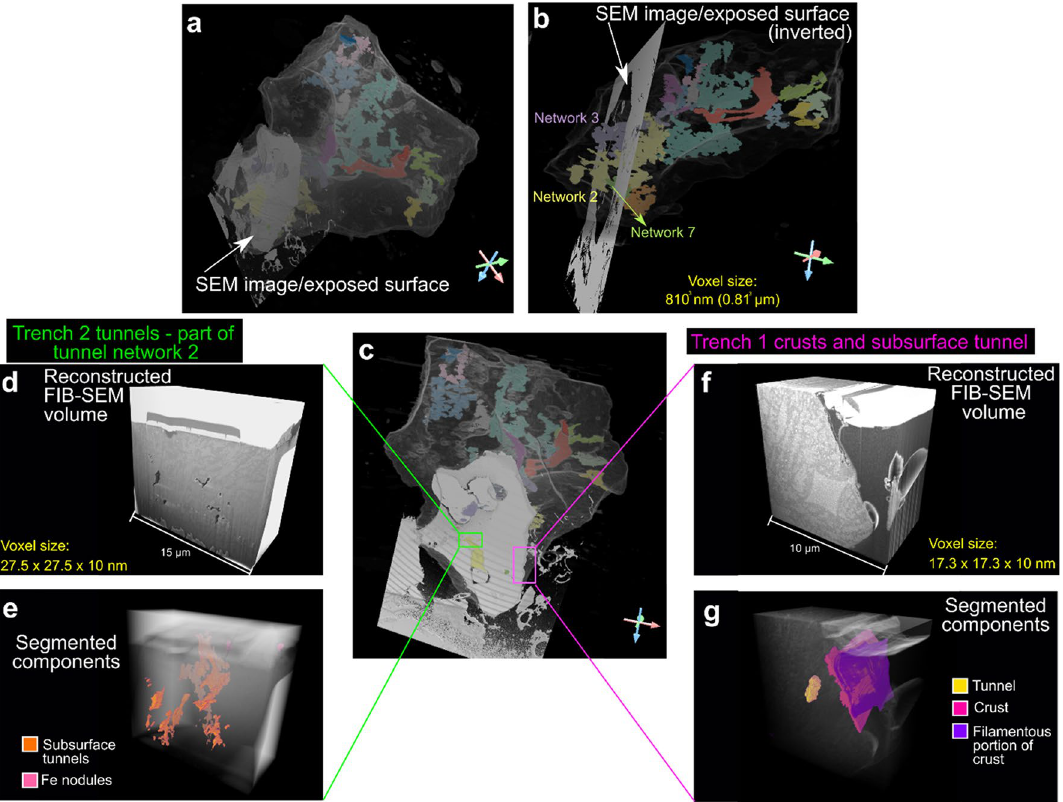
Figure 6. 3D XRM grain with segmented tunnels correlated with SEM image of exposed grain and location of FIB-SEM volumes. (a) Location of SEM image/exposed surface in relation to the entire grain, and which segmented tunnel networks interact with it (networks 2, 3 and 7) (b) . (c) Location of FIB-SEM volumes for trench 2 (tunnels/holes) (d, e) and trench 1 (crusts) (f, g). Trench 2 tunnels are identified as belonging to tunnel network 2 in Fig.